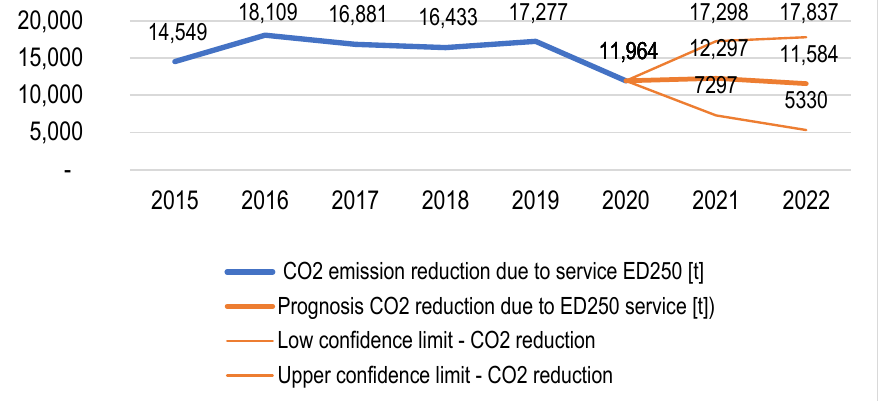
Figure 17. EU ETS savings (2015 – 2020) and forecast EU ETS savings. Source: developed by the au- thors. The presented analysis has confirmed that the decision to put into service high-speed trains in Poland was not only a breakthrough for the railway service market in Poland, but also had positive outcomes for energy consumption and environment in Poland. Since 2015, ED250 trains allowed to reduce over 95,000 tons of CO 2 emissions, which cost, measured by EU ETS prices, was estimated EUR 1.28 million. Assuming 30 years of service, this amount is estimated to be more than EUR 6 million. The use of vehicles with ED250 parameters instead of locomotive trains in the Polish network would contribute to the achievement of transport objectives set out in the Euro- pean Green Deal. In addition, it is worthwhile to mention Poland’ s notification to the TEN-T compre- hensive network of sections of the HSR with an assumed maximum speed of 350 km/h: -